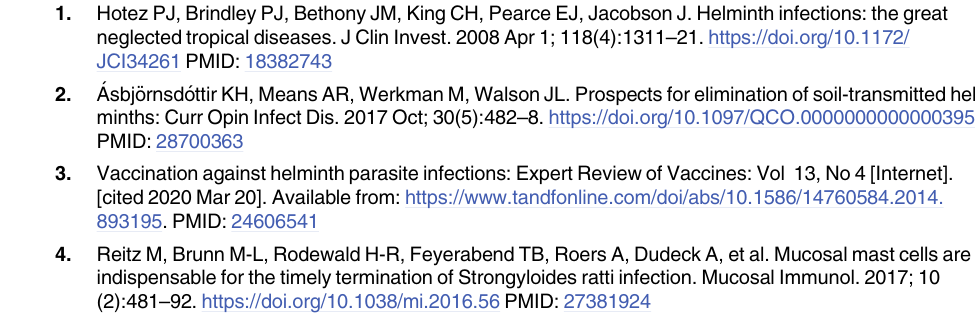
S1 Table. Custom Th2 gene set used for gene set enrichment analysis (GSEA).